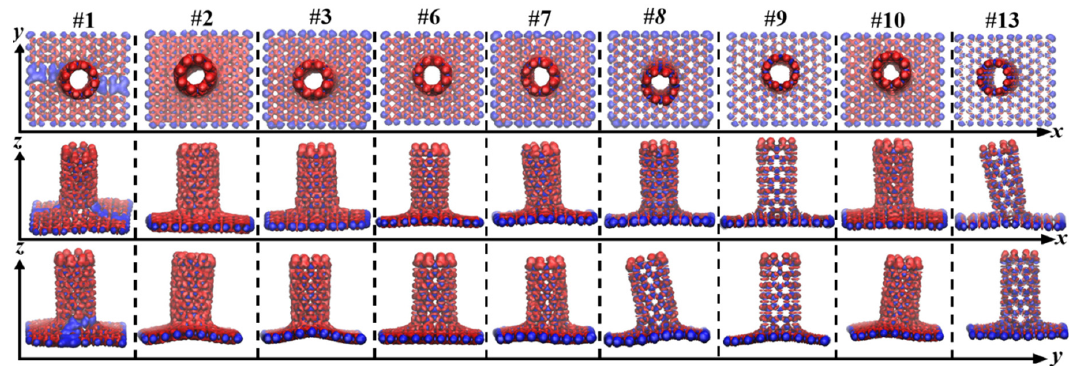
Figure 7. Differential charge density of (8,0)CNT96-graphene for configurations of #1, #2, #3, #6, #7, #8, #9, #10, and #13. #8, #9, #10, and